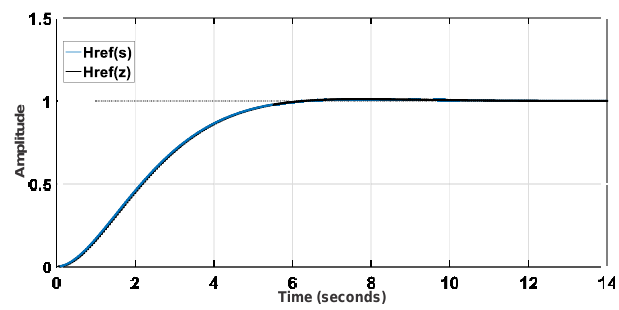
Figure 10. Step response of the reference models.